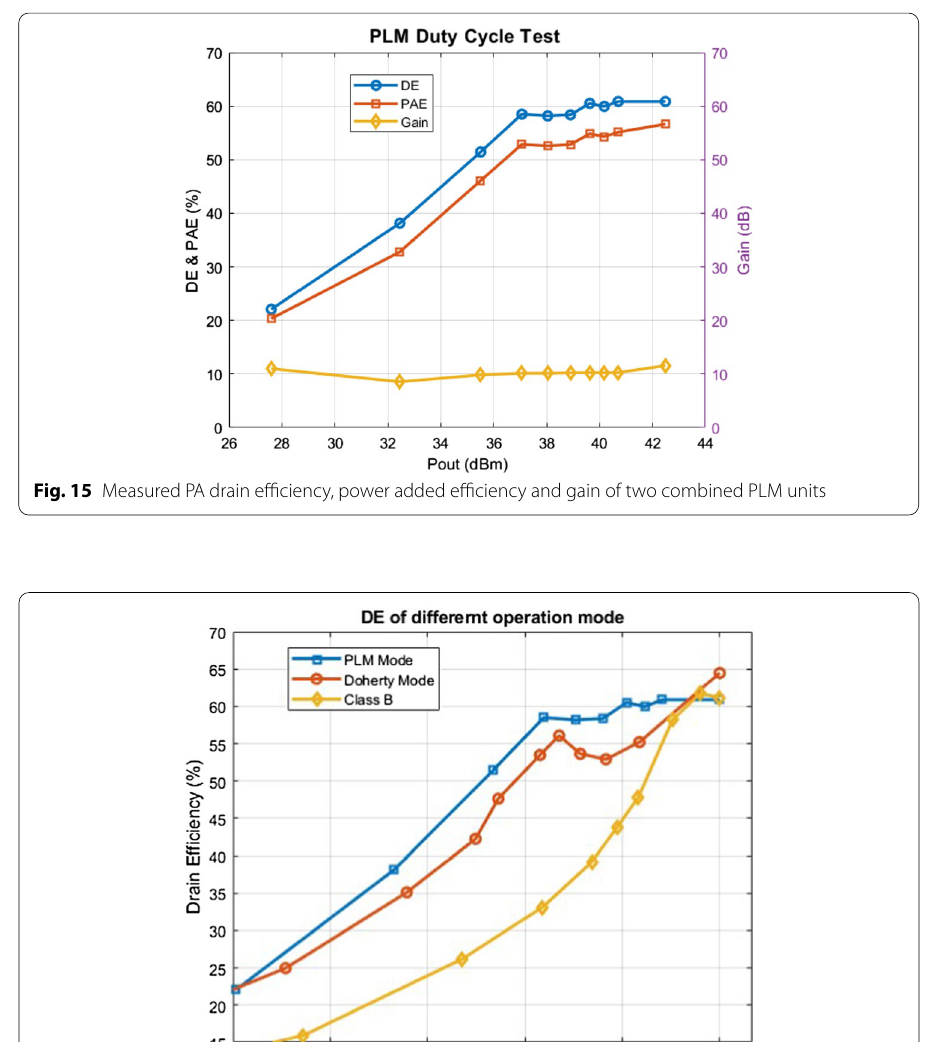
(Fig. 16). A single PLM unit can output a maximum output power of 39.5 dBm with a